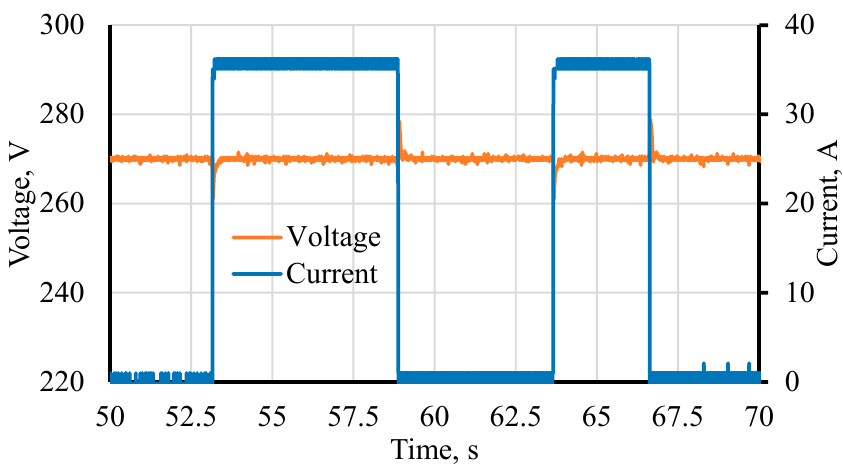
Figure 10. Transient processes during load on/off switching at the generator mode operating.